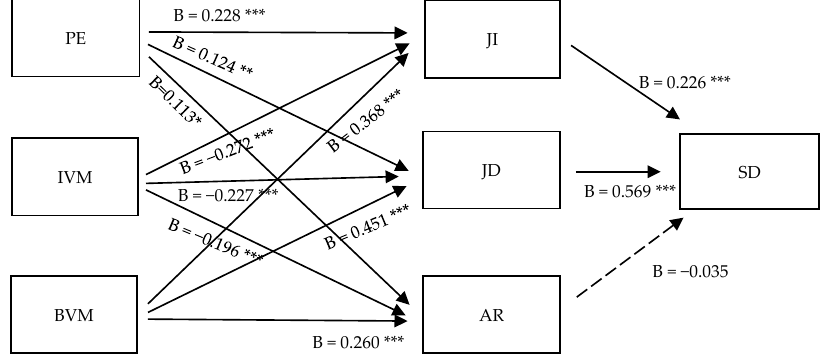
Figure 1. Path model for SD. ** p < 0.01, *** p < 0.001. A solid line denotes statistical significance, but dotted line does not.